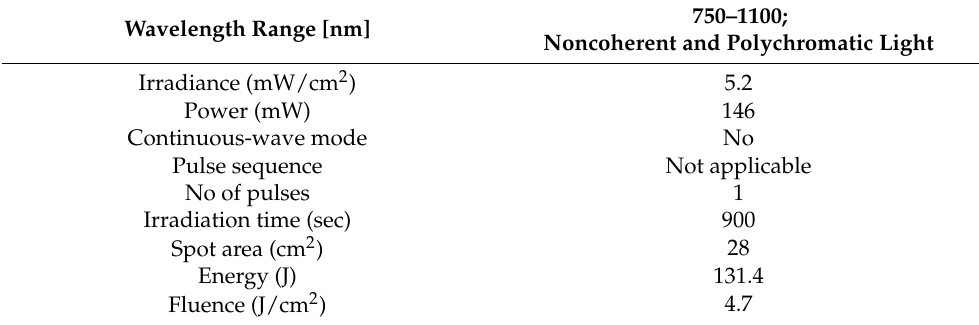
Table 1. Photobiomodulation